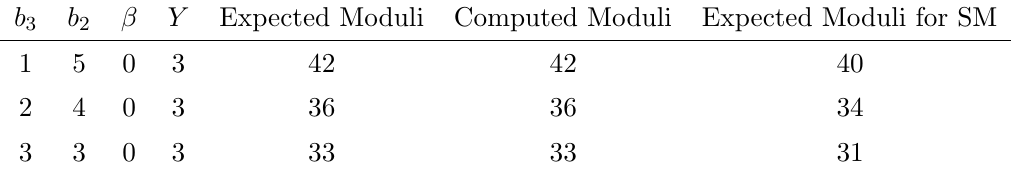
Table 8 . Moduli counting for models with ine(cid:11)ective [ d 2 ] and trivial [ s 1 ], [ s 5 ], and [ s 8 ]. The column labeled \Expected Moduli" gives the number of moduli for the su (3) (cid:8) su (2) (cid:8) u (1) (cid:8) u (1) (cid:8) u (1) model that are expected from 6D anomaly cancellation, given the global gauge group structure consistent with the spectrum in table 7. The column labeled \Computed Moduli" gives the number of moduli calculated from the rank of the Jacobian matrix (7.2). The column labeled \Expected Moduli for SM" gives the number of moduli that would be expected for the (SU(3) (cid:2) SU(2) (cid:2) U(1)) = Z 6 model based on 6D anomaly